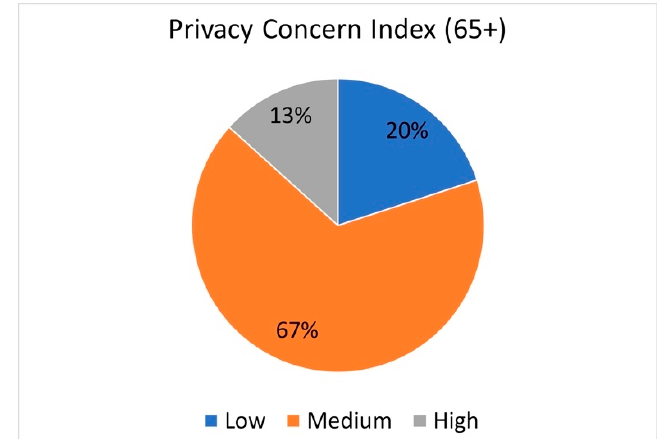
Figure 1. Westin Privacy Concern Index Results.